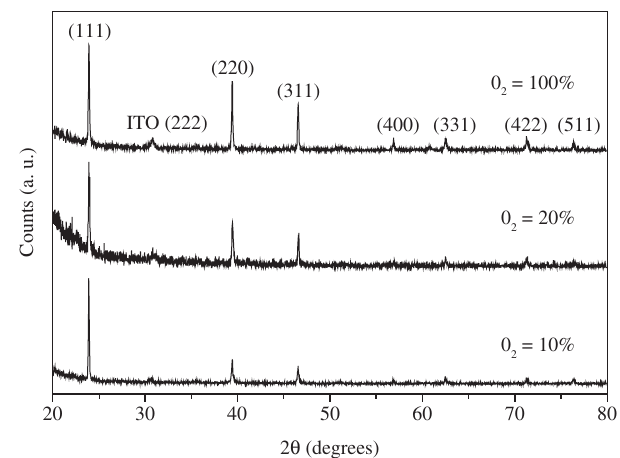
Figure 3. XRD spectra of CdTe films deposited at T P = 10 Torr, using different amounts of oxygen in the gaseous mixt